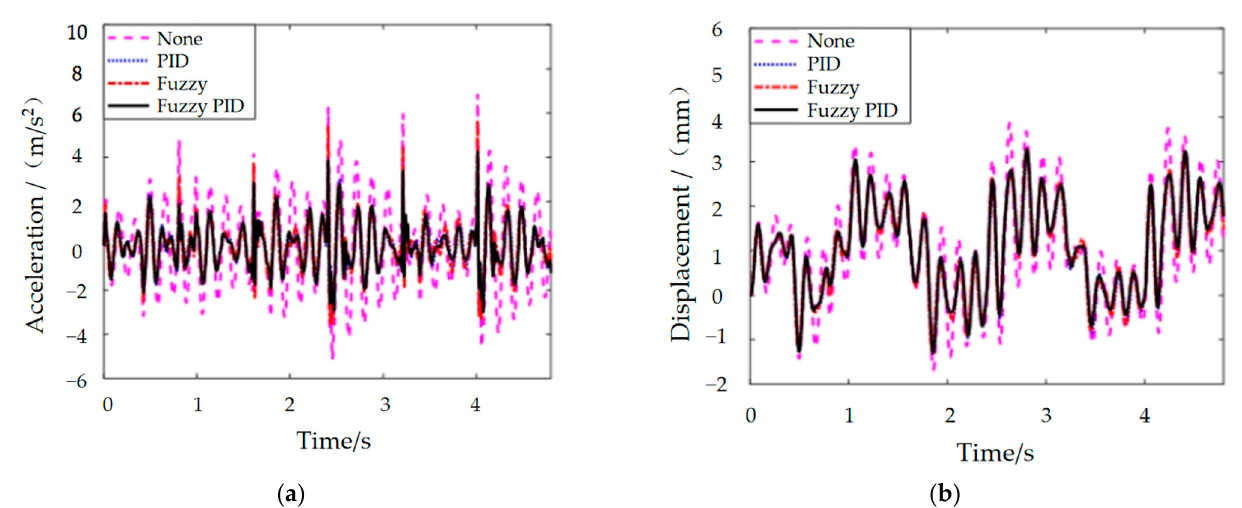
Figure 15. Block diagram of the MRE vibration isolation control system.